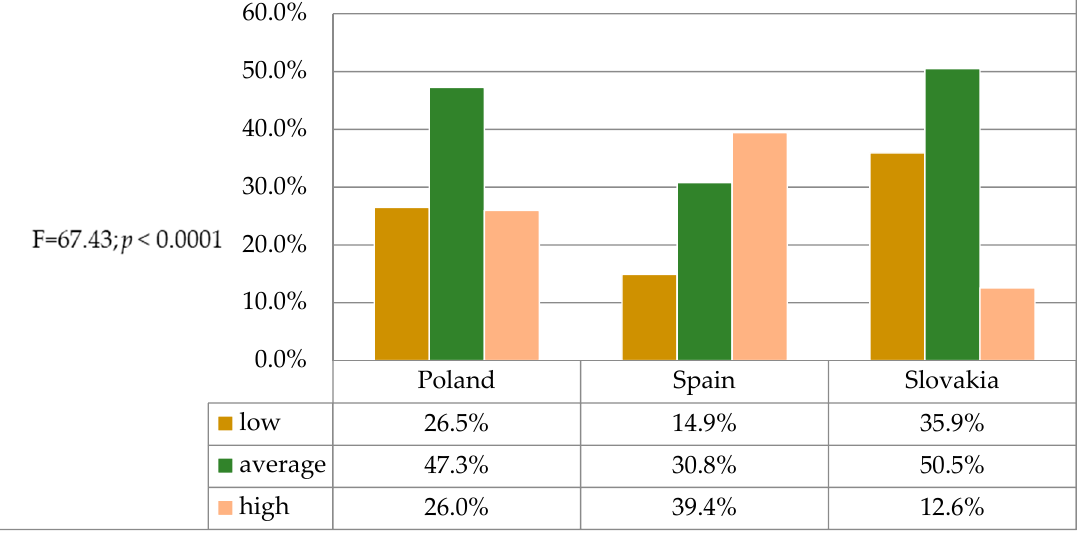
Figure 2. Self-assessment of the level of the students’ knowledge of patients’ rights—distribution of answers.